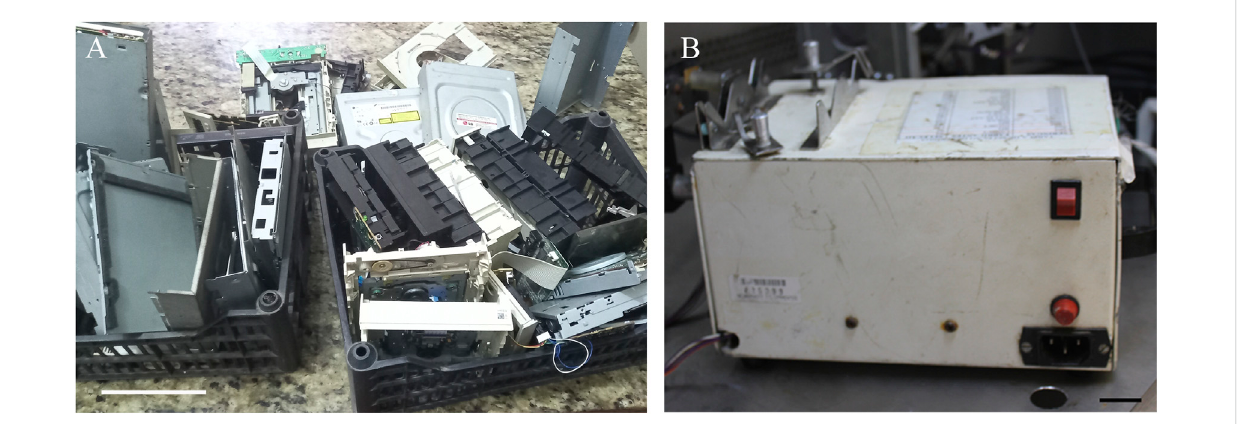
FIGURE 1 Representativeimageoftherecycledscrapmaterialusedtobuildthescrapmetal-basedlow-costbioprinter. (A) CD,DVDdrivers,andacrylicpieces. Scale bar: 10 cm. (B) Injection subsystem: Representative images of the equipment used for the injection subsystems within the extrusion system. Scale bar: 2